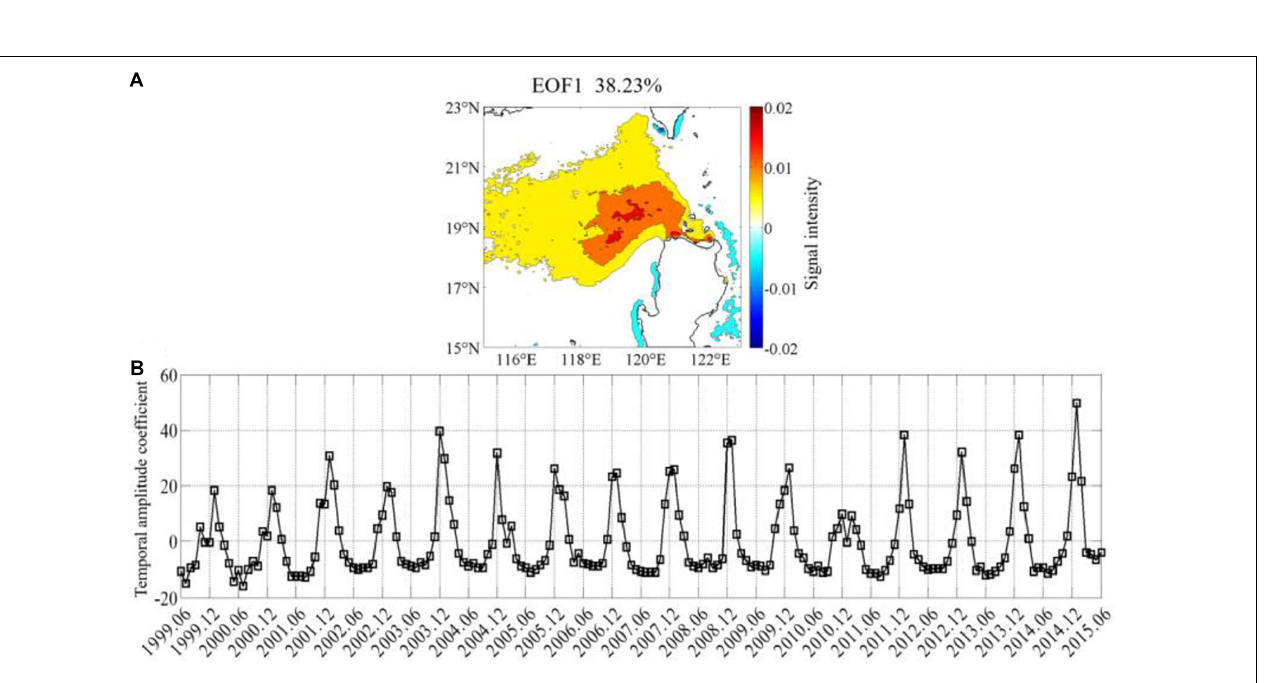
Frontiers in Marine Science |